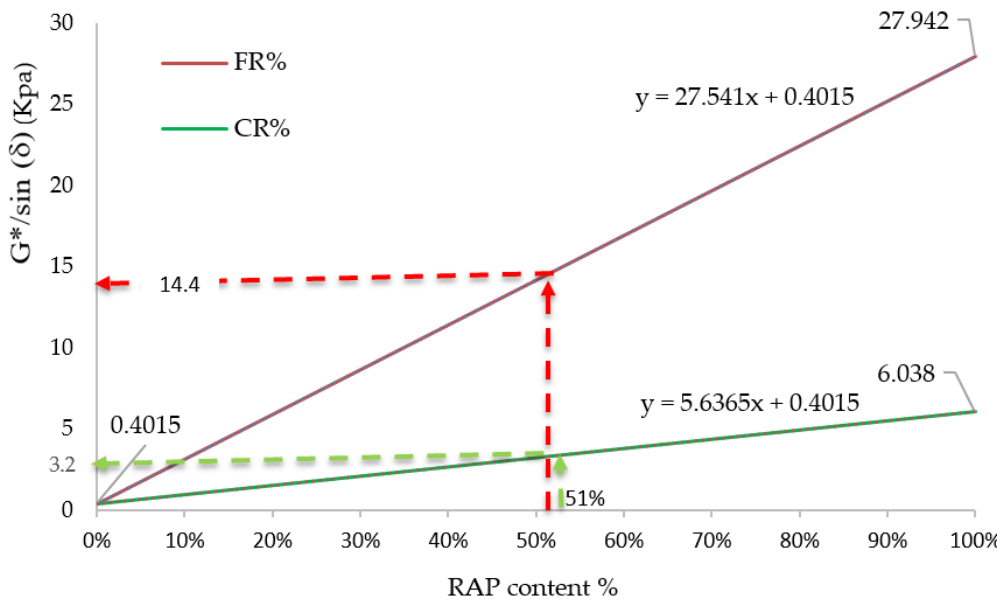
Figure 4. Blending charts for the fine and coarse RAP mixes at 70°C and 1.6 Hz.